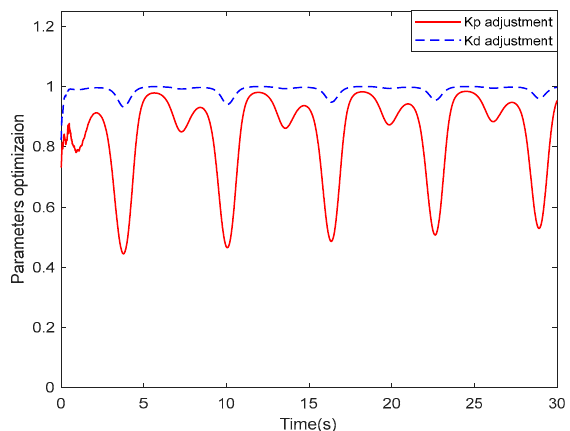
Figure 17. Comparison result of tracking errors between the DRNN-LADRC and BPNN-LADRC.